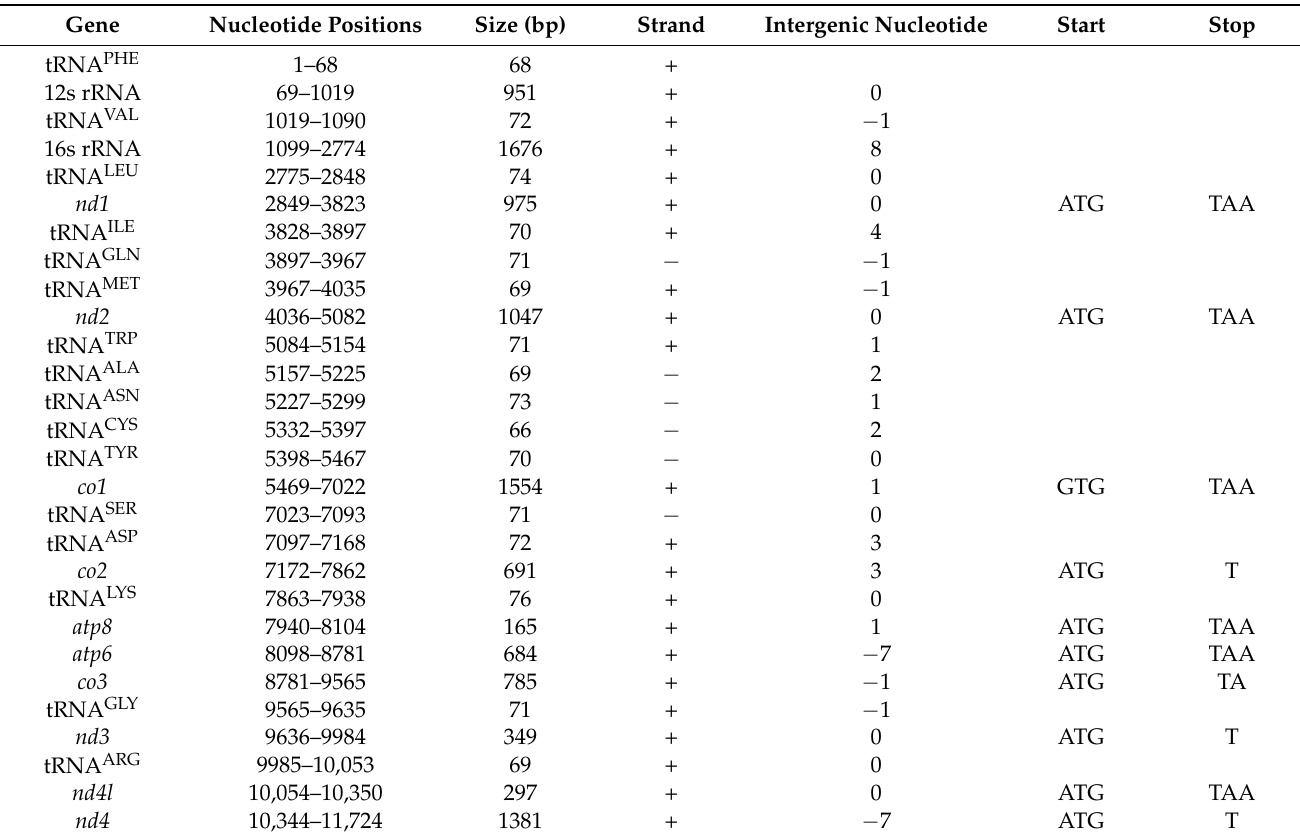
Table 4. Characteristics of the mitochondrial genome of Rhinogobius wuyanlingensis